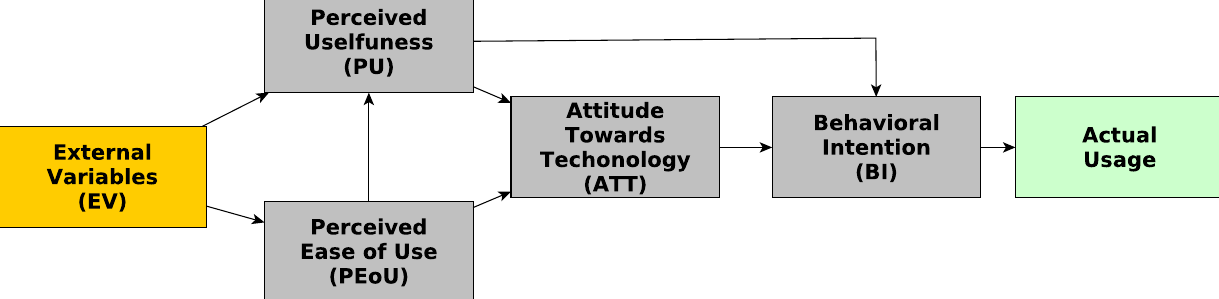
Figure 2. TAM Model diagram based on